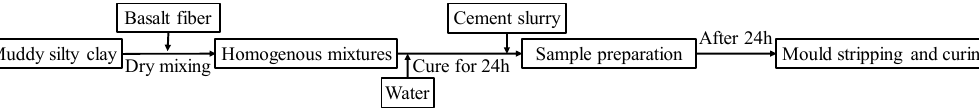
Figure 3. The mixing procedure of cement soil reinforced with basalt fiber.